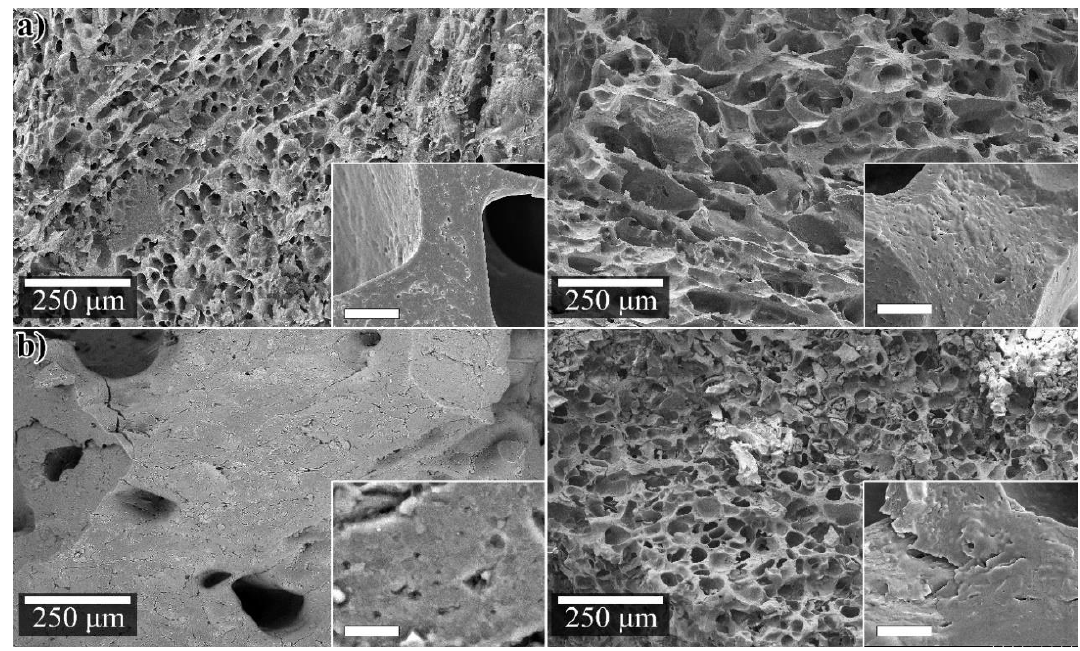
Figure 3. ( a ) WG(f) (left), WG(f) after 24h swelling (right); ( b ) WG 5G5S LT (left), after 24h swelling and lyophilized (right). The bar in the insert indicates 5 µm.